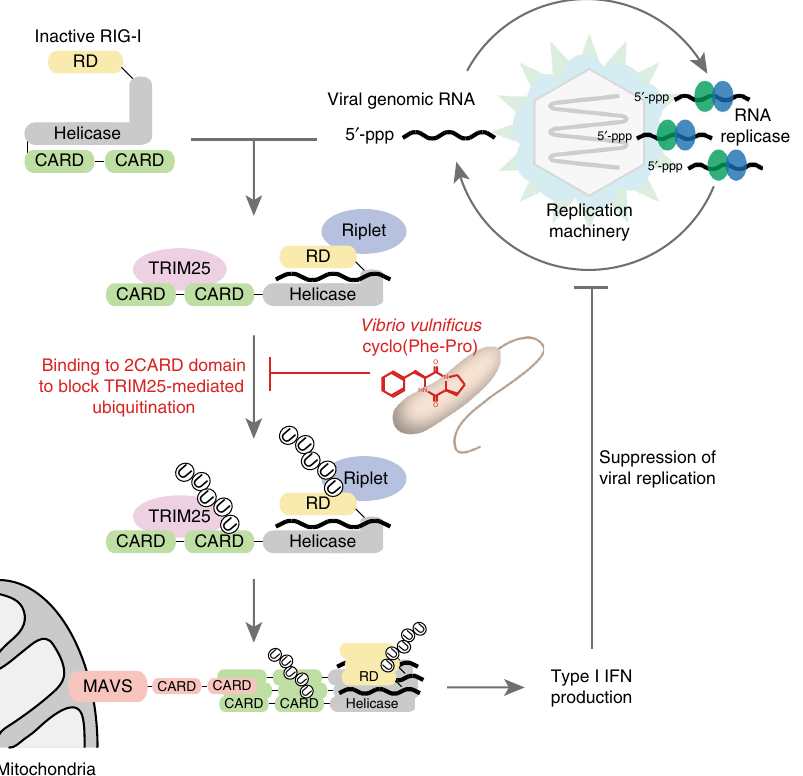
Fig. 8 Model for V. vulni fi cus cFP-mediated dysregulation of host innate immune responses. cFP promotes propagation of RNA viruses that are sensed by RIG-I, but not the ones inducing type-I IFN production through MDA5. It binds to the RIG-I CARD domain and induces a conformational change to block RIG-I polyubiquitination essential for induction of antiviral innate immune responses. The inter-pathogen crosstalk mediated through a quorum sensing molecule from pathogenic microbes may play an important role in determining the outcome of virus – host